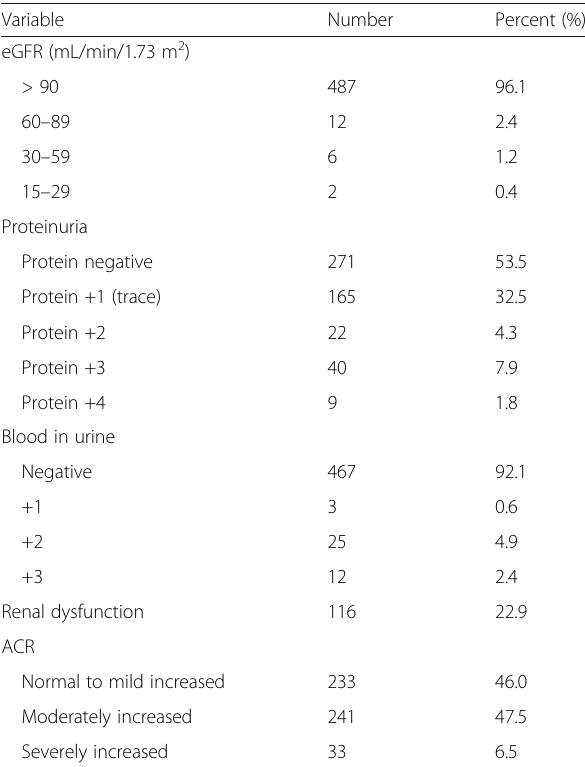
Table 2 Laboratory renal abnormalities among 507 study